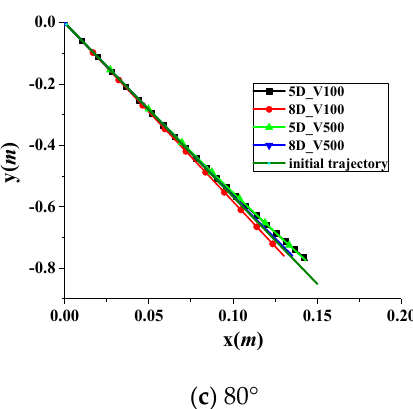
Figure 6. Trajectory curves of water entry for different initial inclination angles: ( a ) 10°, ( b ) 45°, ( c ) 80°.